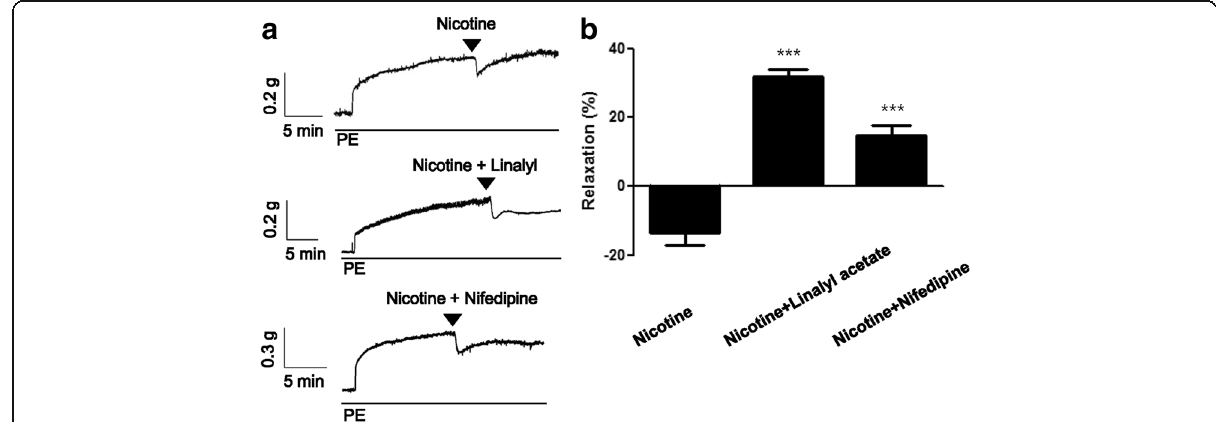
Fig. 3 Vascular-related effects of linalyl acetate plus nicotine. a Original trace of tension measurements. b Relaxation effects of nicotine, with or without linalyl acetate, on phenylephrine (PE)-induced contractions in mice. *** p < 0.001 compared with nicotine group. PE: phenylephrine